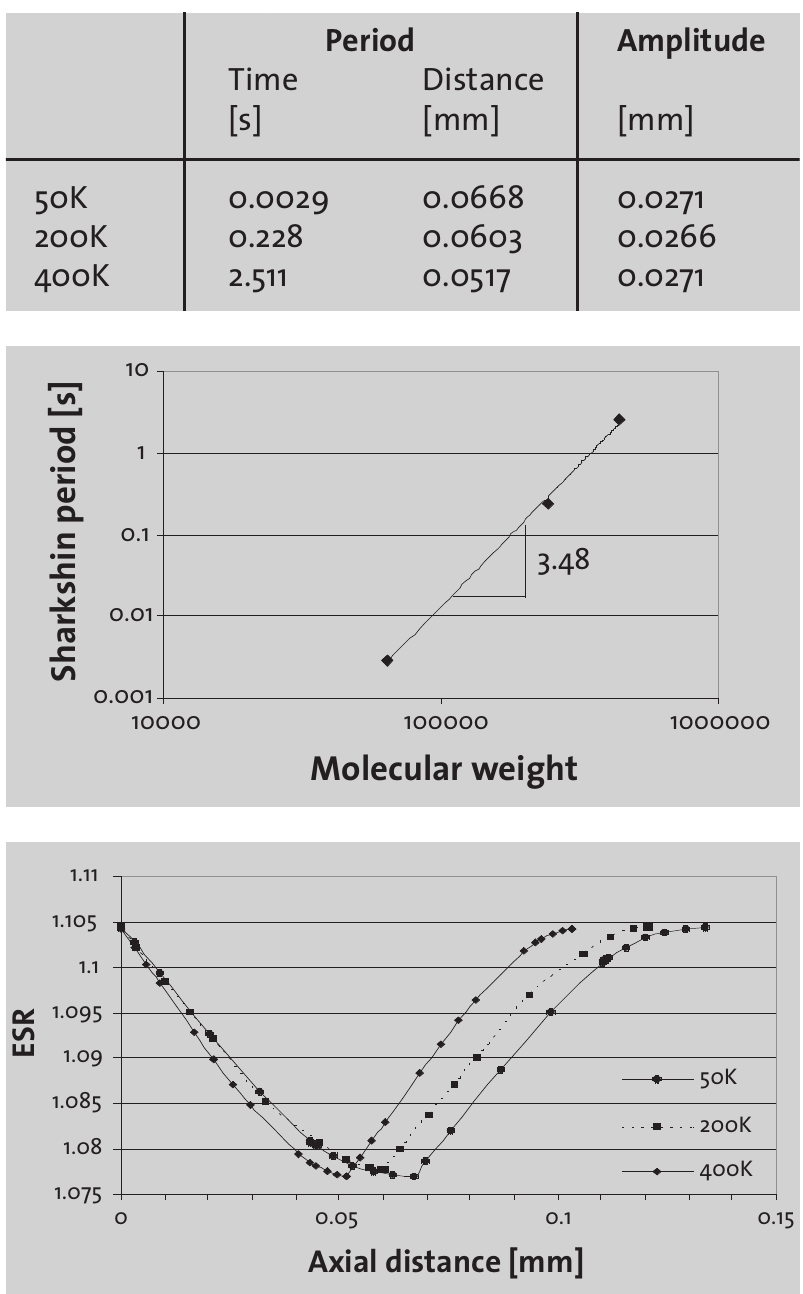
Table 1 (left above): Calculated values for the period and amplitude of simulated sharkskin. Figure 8 (left middle): Sharkskin time period and molecular weight. Figure 9 (left below): Simulated sharkskin results of polybutadiene